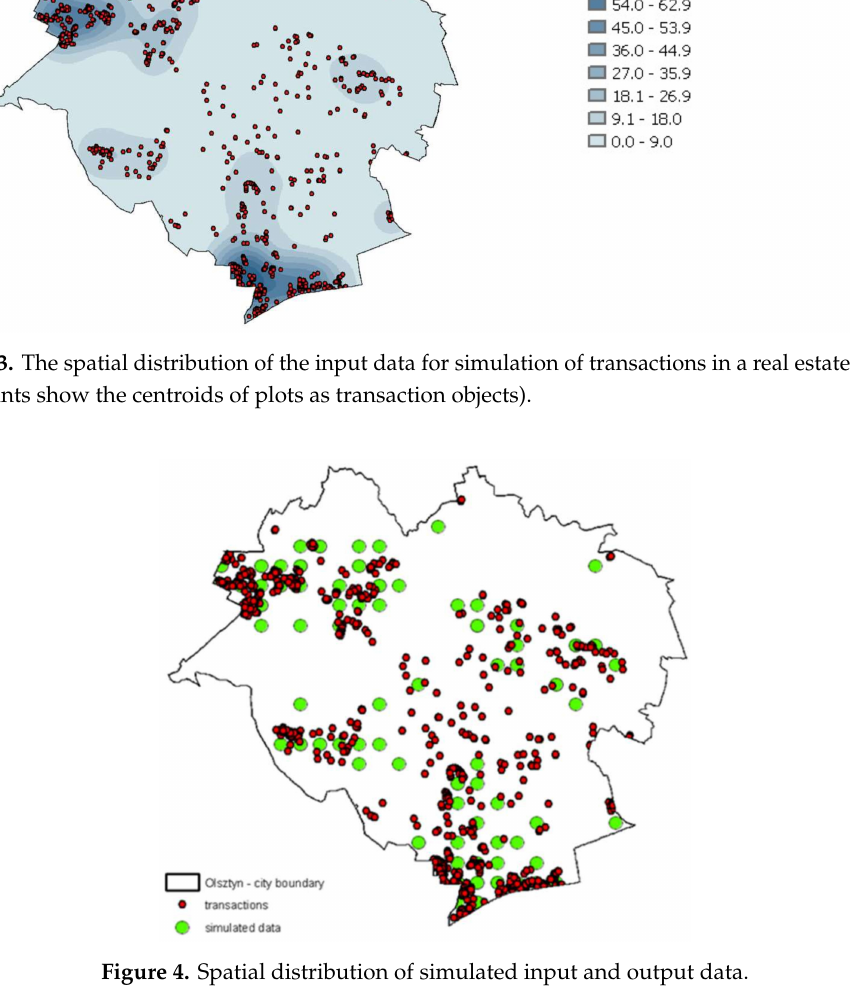
Figure 4. Spatial distribution of simulated input and output